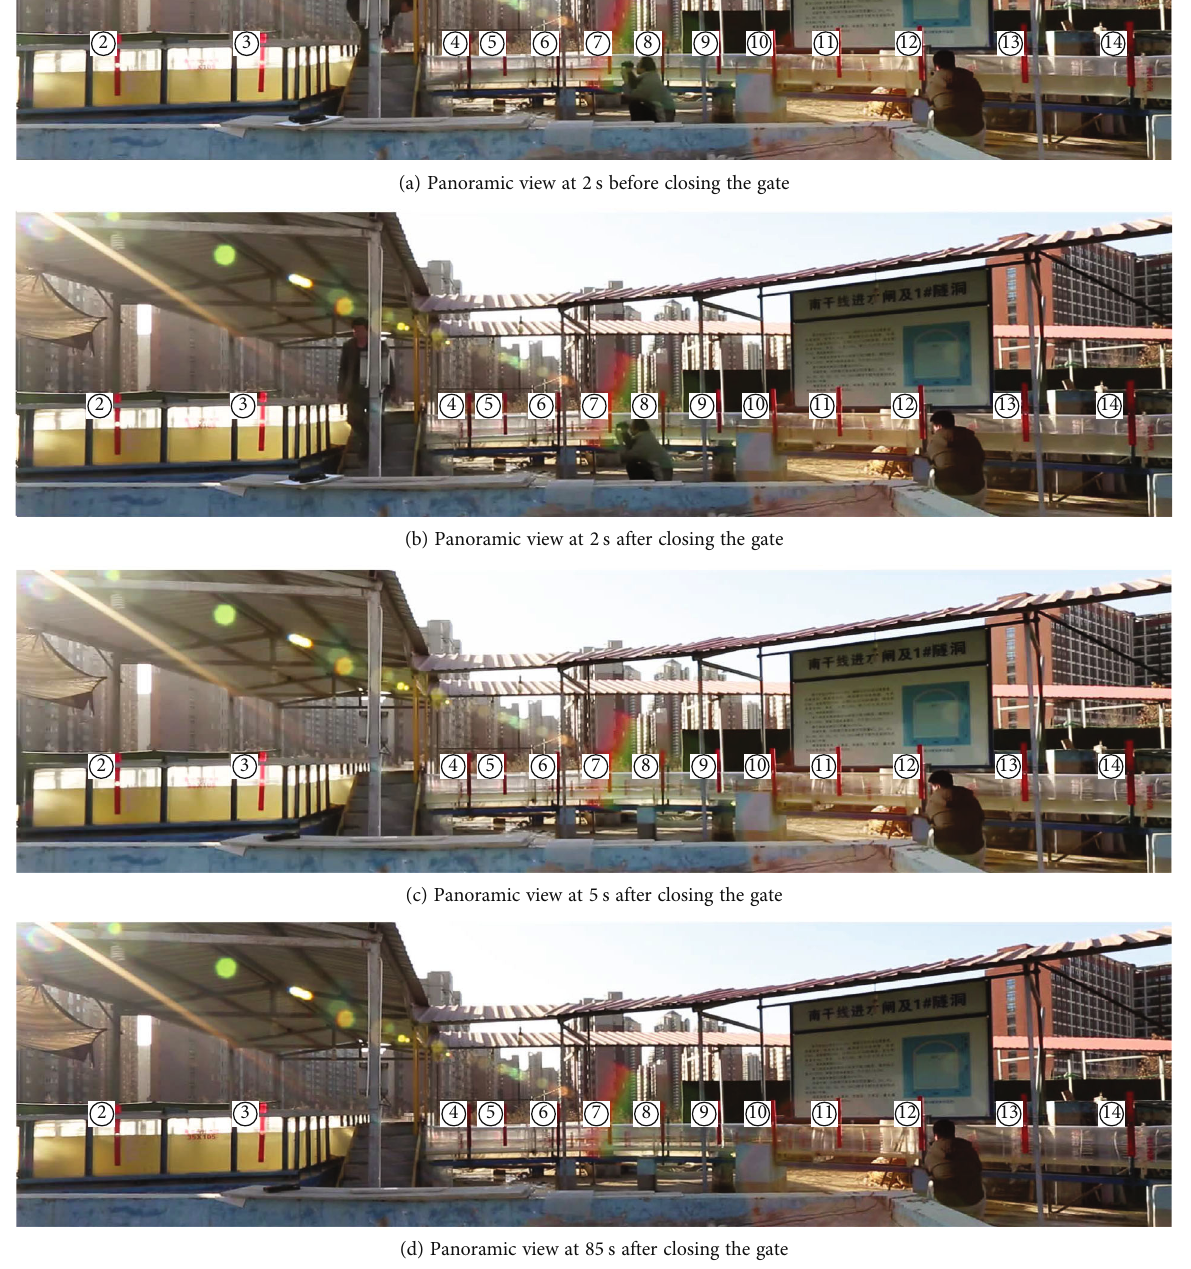
Figure 4: Instantaneous water surface images in the Water Distribution Pool and the Southern Main Tunnel under operating condition